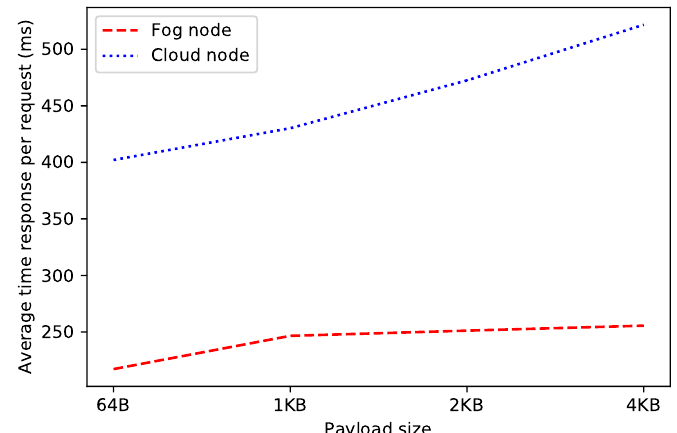
Figure 11. Average response time of OrbitDB when running it on fog and cloud nodes.